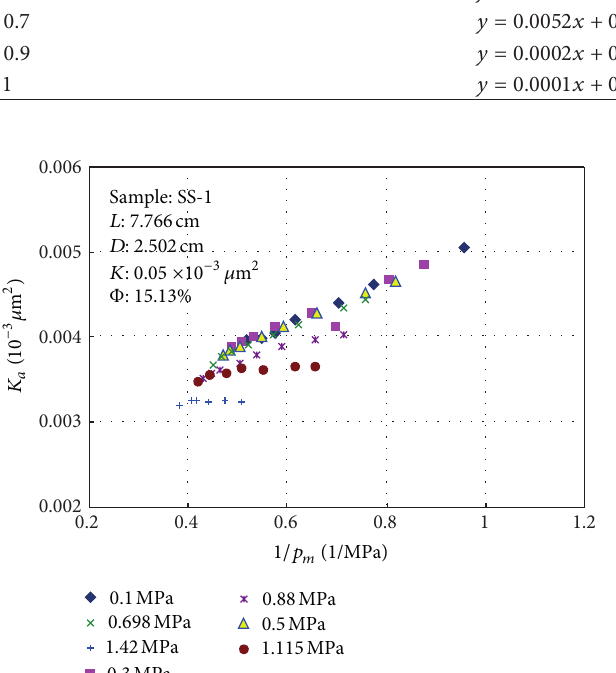
Figure 6: Relationships between 1/𝑝 𝑚 and 𝐾 𝑎 at various backpres- sures for sample